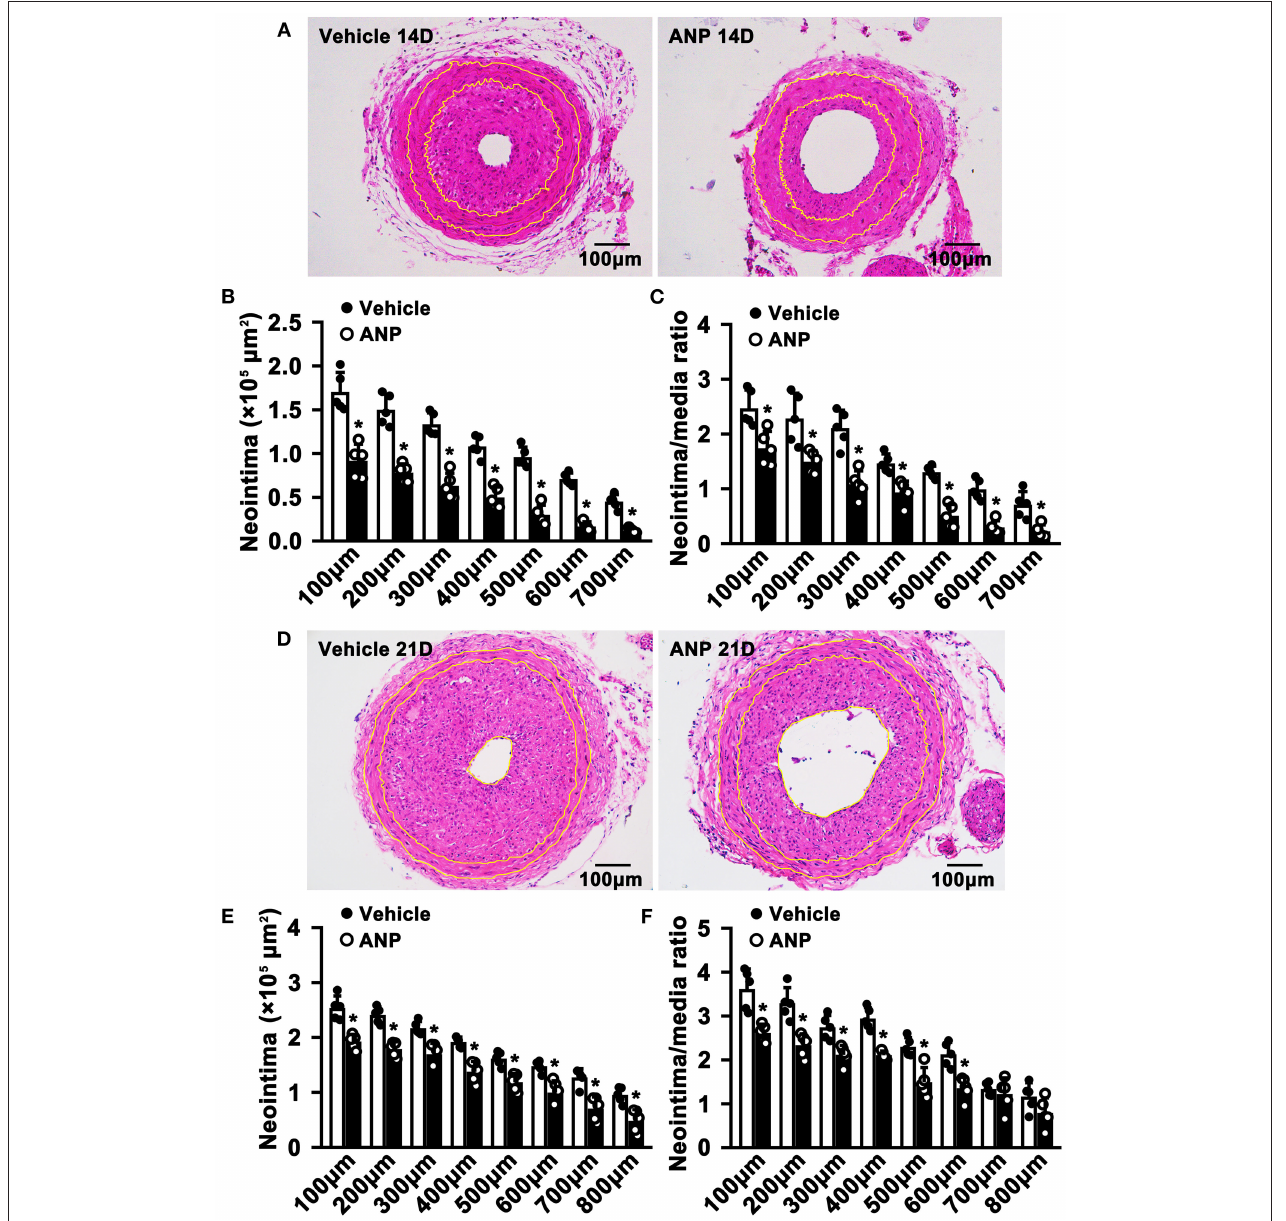
FIGURE 1 | Andrographolide attenuates neointima hyperplasia induced by vascular ligation injury. (A) Complete ligation of the left common carotid artery in C57BL/6 mice, and following Andrographolide treatment (10 mg/kg) by intraperitoneal injection for 14 consecutive days. The arteries were harvested and paraffin-embedded. Slides of 5 µ m thickness at different locations from the ligation site were collected. H&E staining was performed to visualize vascular morphological changes. (B,C) Analysis areas of the neointimal hyperplasia and ratio of the neointimal areas to the medium layer area ( n = 5). (D) Andrographolide (10 mg/kg) was administered by intraperitoneal injection for 21 consecutive days, the representative image of H&E staining. (E,F) Analysis areas of the neointimal hyperplasia and ratio of the neointimal areas to the medium layer area ( n = 5). Data are expressed as mean ± SEM. * P < 0.05